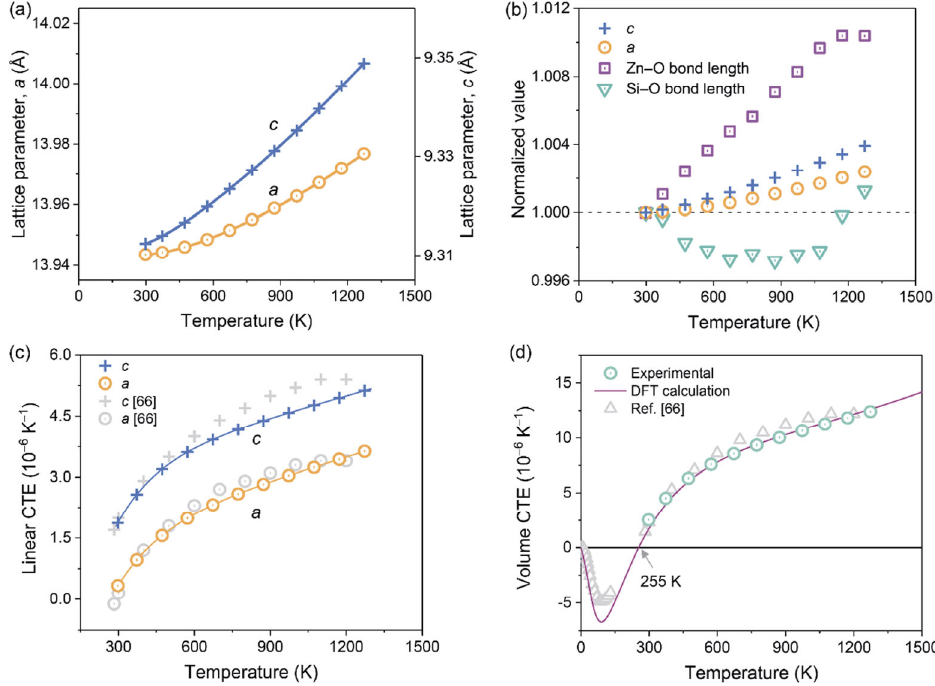
Fig. 8 Temperature dependence of the thermal expansion in Zn 2 SiO 4 . (a) Lattice parameters, (b) normalized lattice parameters and mean bond lengths, (c) linear CTE, and (d) volume CTE. The data in (a  c) are calculated from the XRD experiment, and those in (d) are from DFT calculation and the XRD